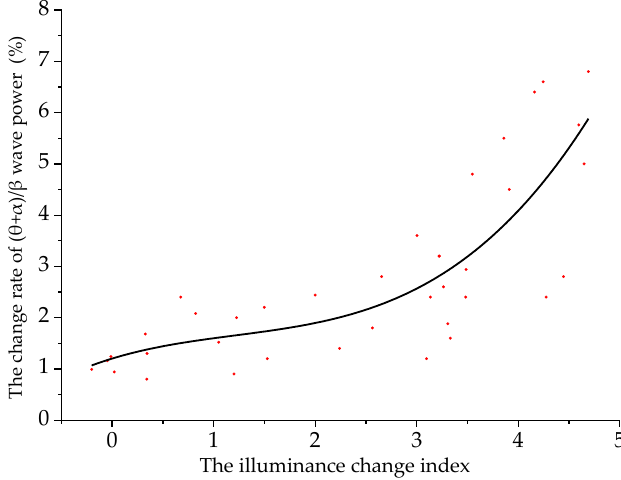
Figure 6. Fitting curve of illuminance change index and ∆ P ( θ + α )/ β